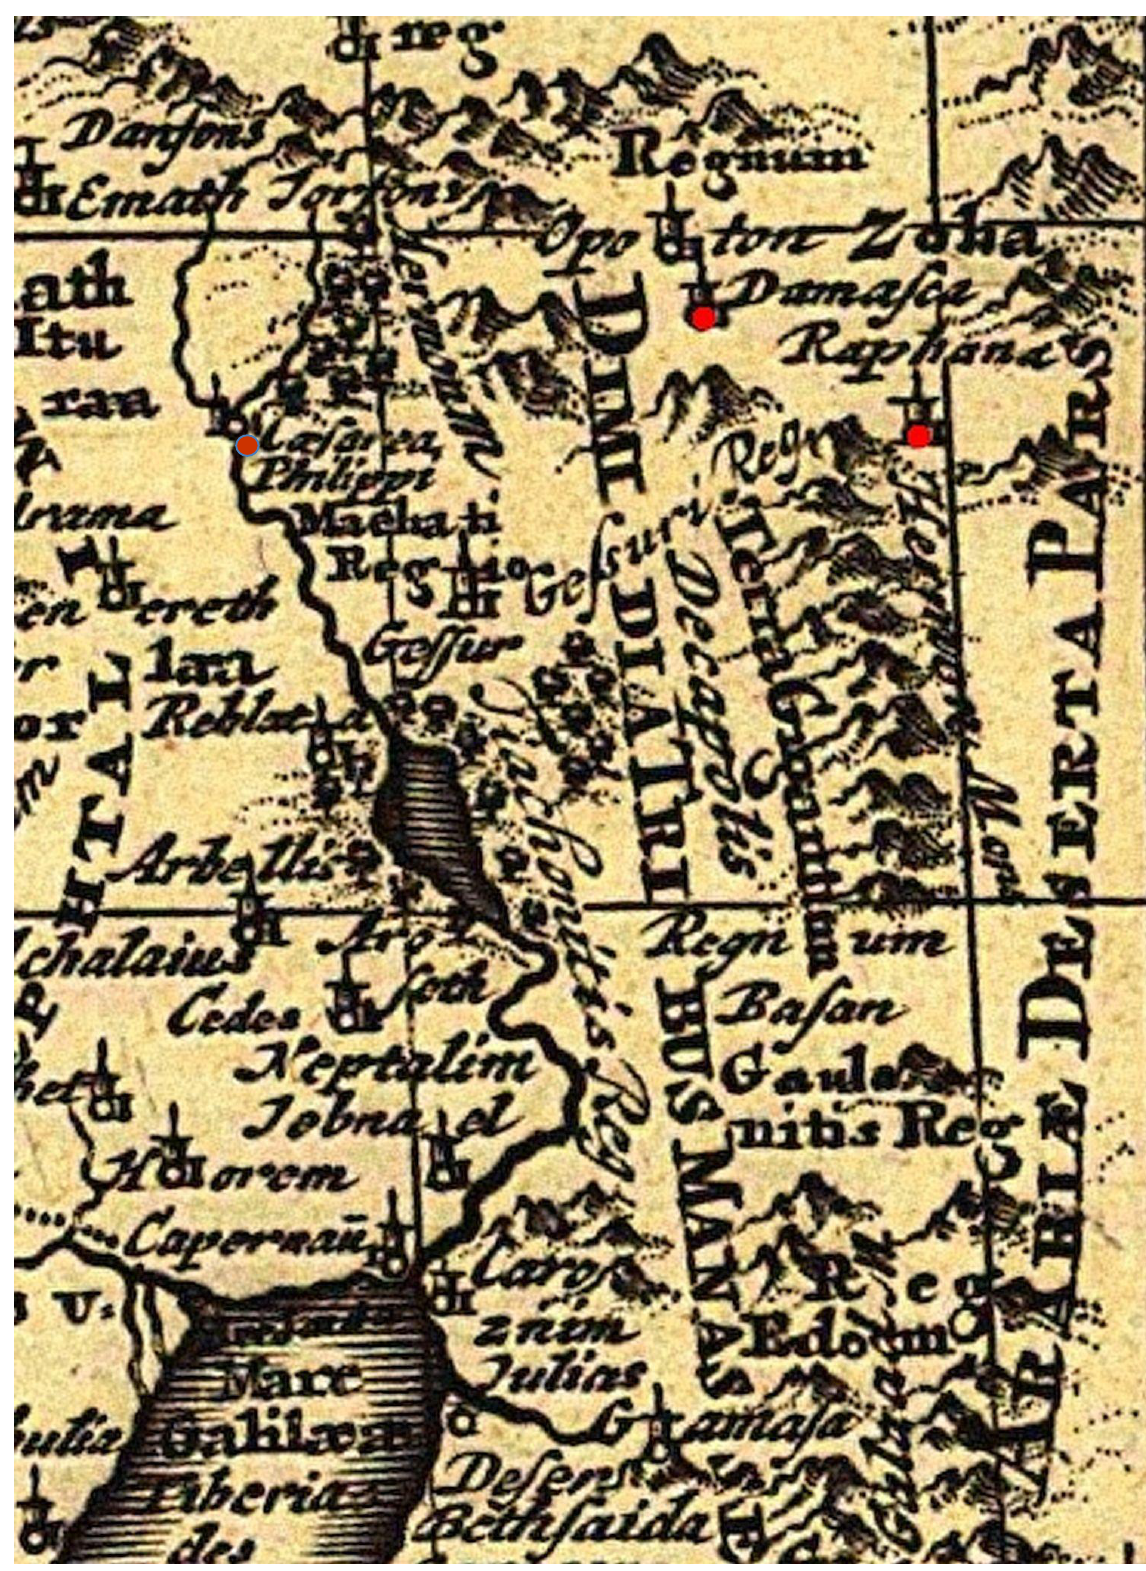
Figure 1: Detail of a map drawn by Ph. Cluever 1580-1622, “Terrae Sanctae,” with Damascus and Raphana to the southeast (red dots), which are positioned at nearly the same latitude as the ancient Roman city of Caesarea Philippi (Courtesy of the Library of